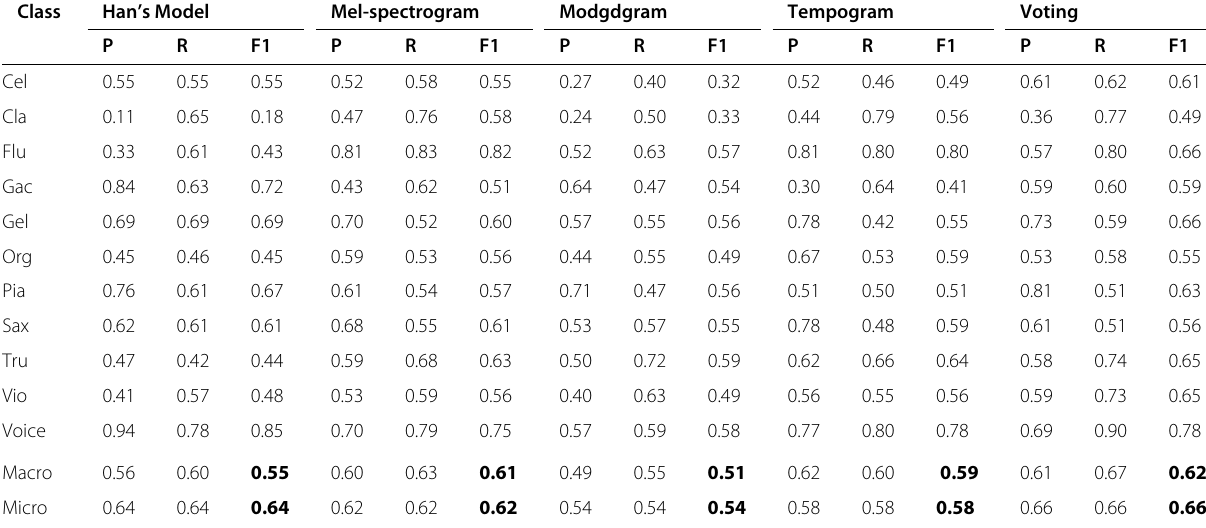
Table 3 Precision (P), recall (R), and F1 score for the Swin-T experiments and Han’s model with data augmentation